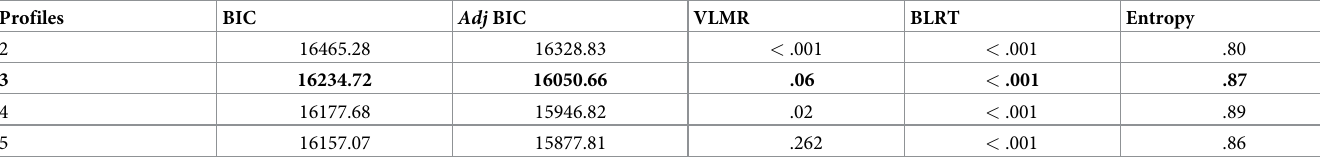
Table 5. Model fit indices for 2- through 5-profile solutions for poultry farmers.